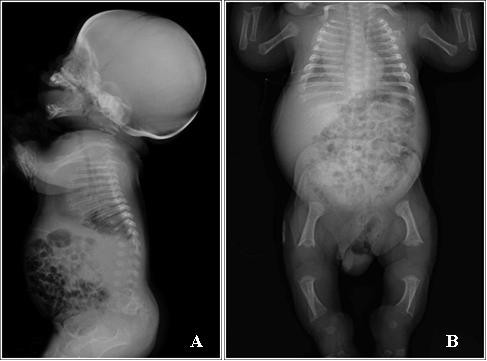
Radiological features of patient 2. There is retarded ossification of the skeleton with absence of the ossification centres of pubic bones and distal femoral and proximal tibial epiphyses. Mild platyspondyly with ovoid-pear-shaped vertebral bodies. The tubular bones are short and broad with splayed ends and cupped metaphyses and mild bowing of the tibiae.